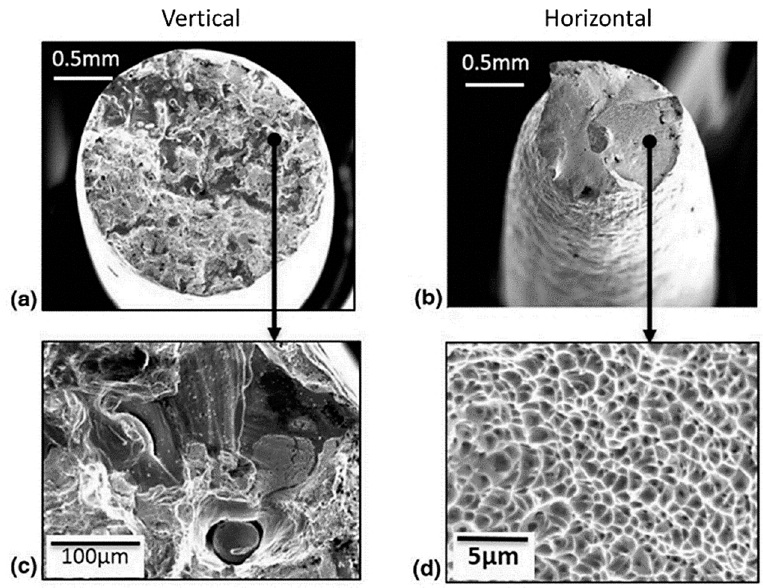
Figure 13. SEM micrographs of the tensile fracture surface: ( a , c ) vertical; ( b , d ) horizontal [84].